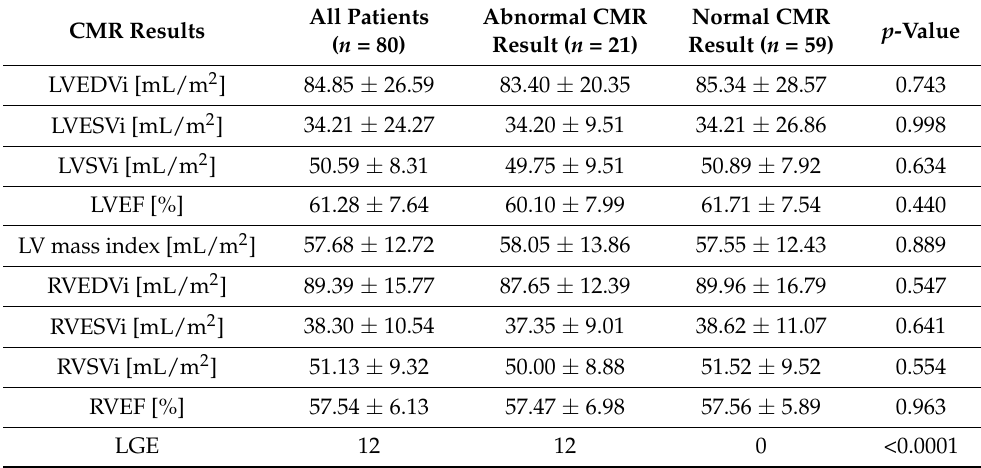
Table 3. CMR measurements in association with study endpoints.